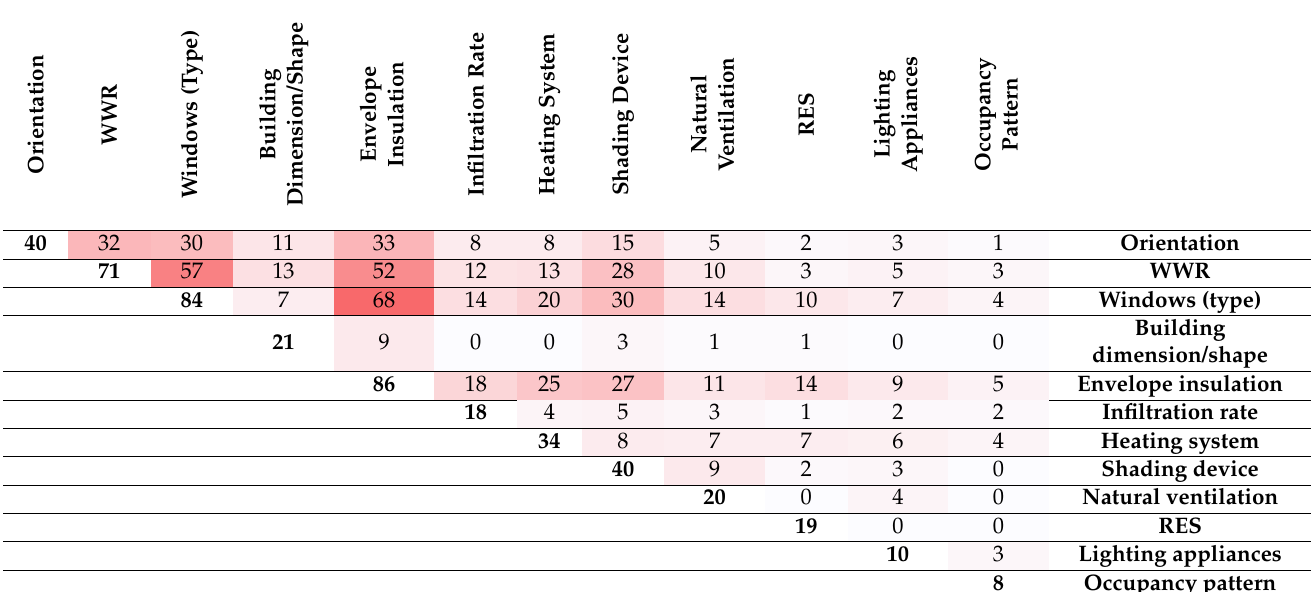
Table 2. The number of publications per each couple of optimization variables (i.e., there are 32 journal articles that optimize WWR and orientation at the same time). Color transparency is inversely proportional to the number of publications. The white color corresponds to zero, whereas the red color corresponds to the highest amount